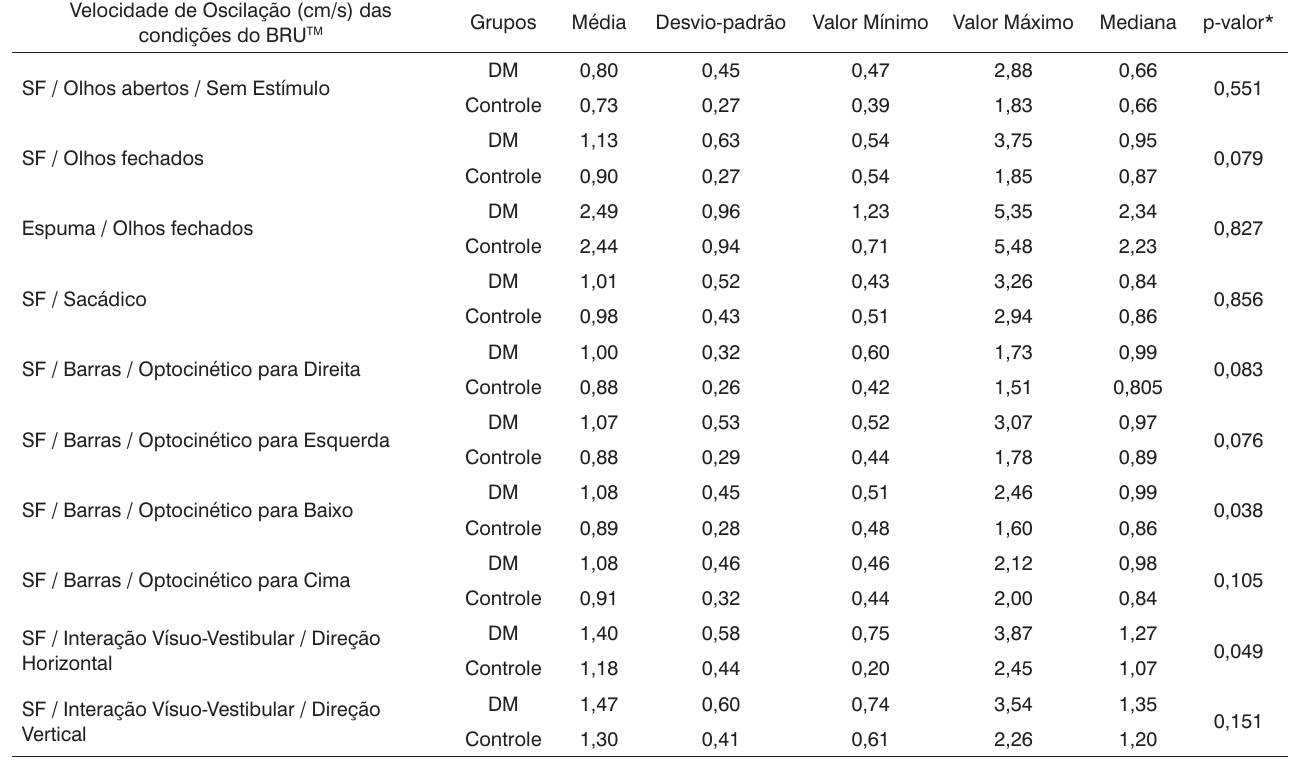
Tabela 1. Valores descritivos e análise comparativa da velocidade de oscilação (cm/s) das condições do Balance Rehabilitation Unit (BRU TM